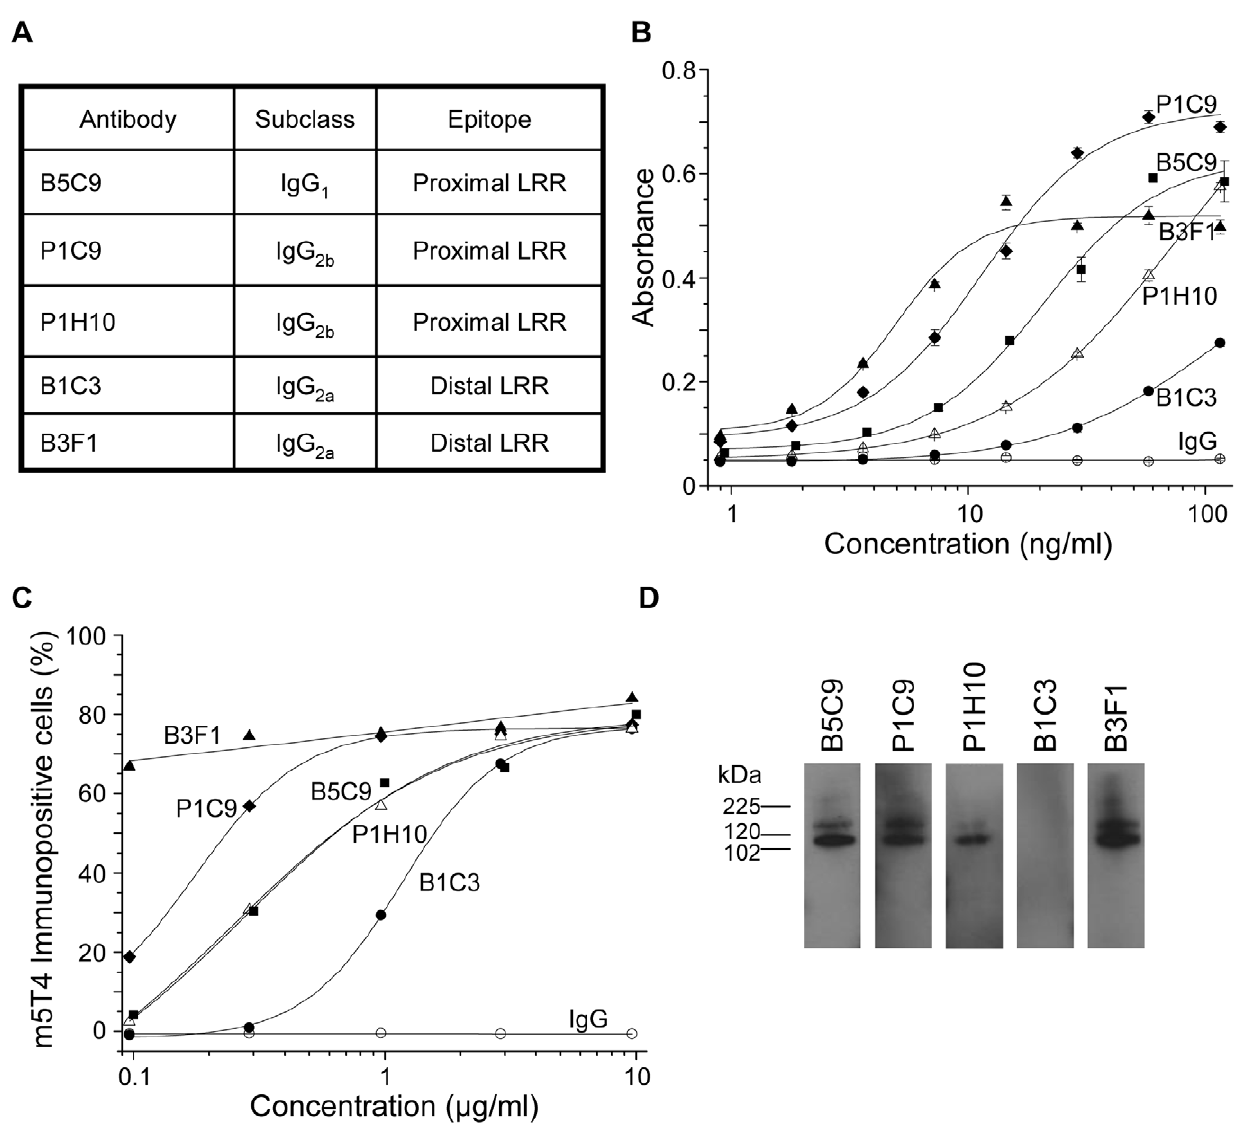
Figure 8. Characterization of m5T4 specific mAbs. (A), Summarizes the IgG subclasses of five m5T4 specific monoclonal antibodies (mAb, made in 5T4KO mice) recognizing distinct epitopes in the proximal and distal 5T4 extracellular LRR containing domains. (B), Shows titration of mAb activity in m5T4 specific ELISA [27]. (C), Shows titration of mAb cell surface labeling of B16m5T4 tumor cells by flow cytometry. (D), Western blot analysis of mAb probing against recombinant m5T4-pIg showing recognition of m5T4 by all mAbs except